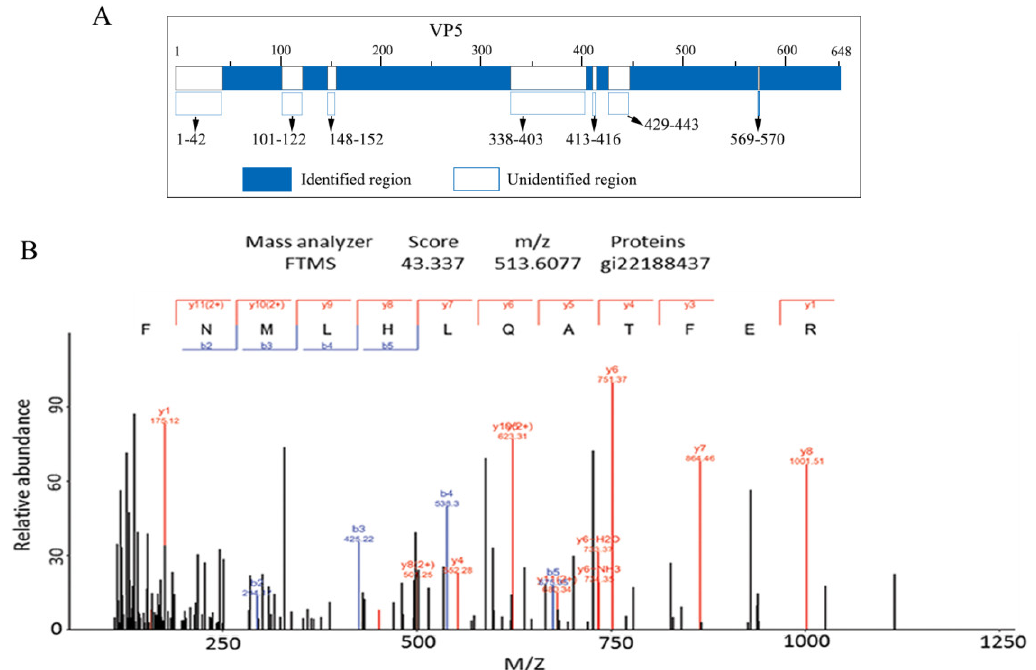
Figure 2. Identification of the tryptic peptide of GCRV VP5 using LC-MS/MS. ( A ) Diagrammatic representation of VP5 tryptic fragments accounted for 492 of the 648 predicted aa in VP5 (76% coverage). ( B ) LC-MS/MS spectra of a tryptic peptide ion of VP5 fragment using in-gel tryptic digestion. GCRV, grass carp reovirus; LC-MS/MS, liquid chromatography-tandem mass spectrometry.